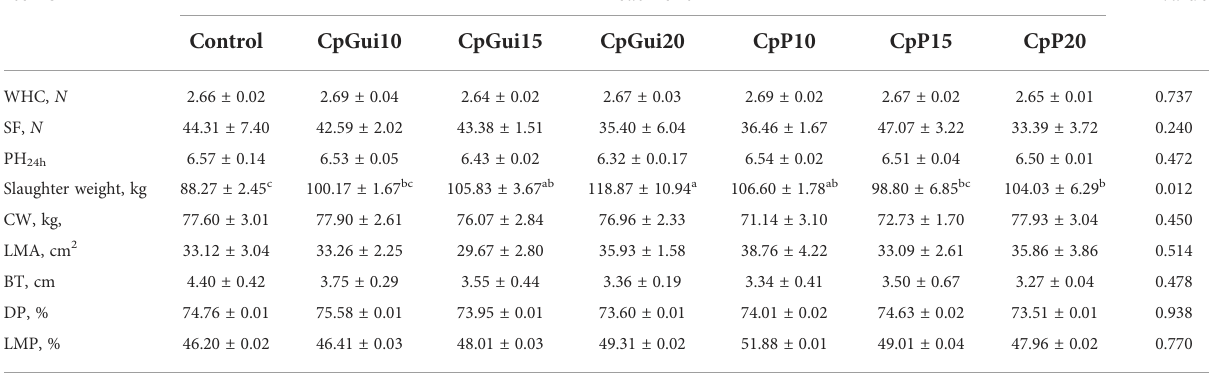
TABLE 3 Carcass characteristics in fattening pigs with different feed composition diets.